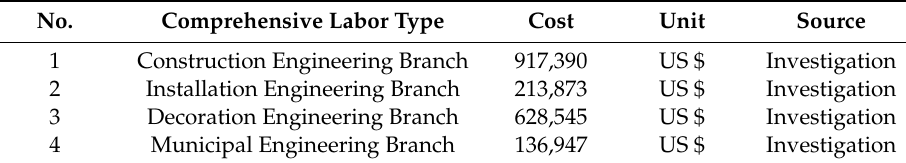
Table 4. Comprehensive labor cost.